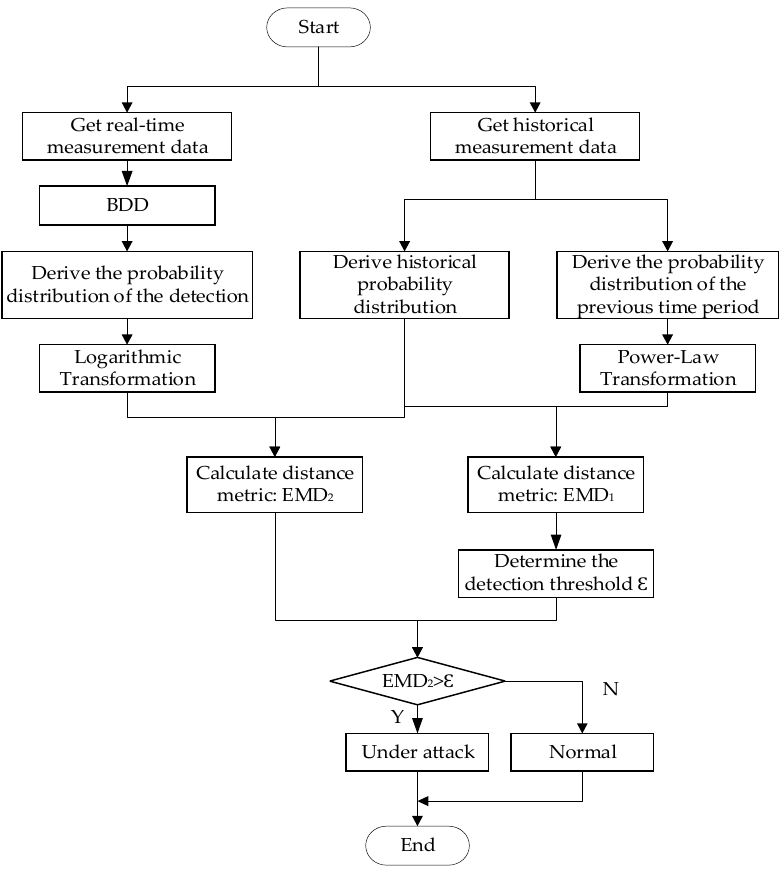
Figure 1. Process of FDIAs detection method.